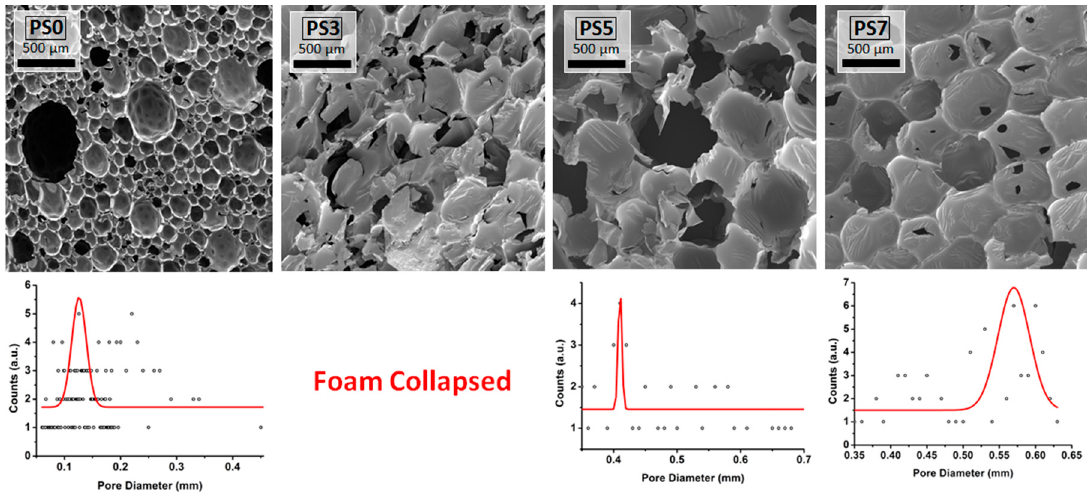
Figure 7. Scanning electron microscopy (SEM) micrographs of produced PS0, PS3, PS5 and PS7.